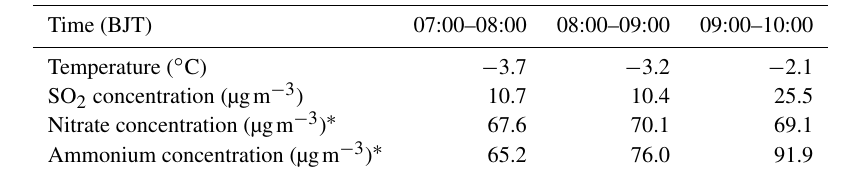
Table 2. Box model configurations.